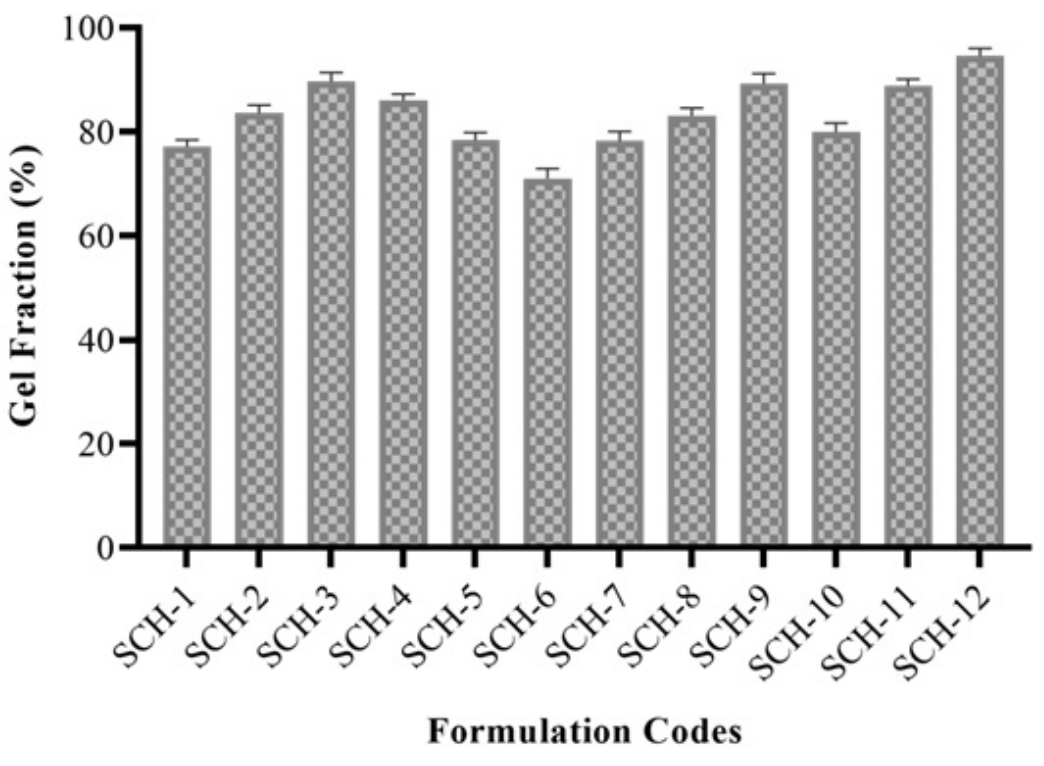
Figure 4. Gel fraction (%) of developed formulations (SCH-1 to SCH-12).